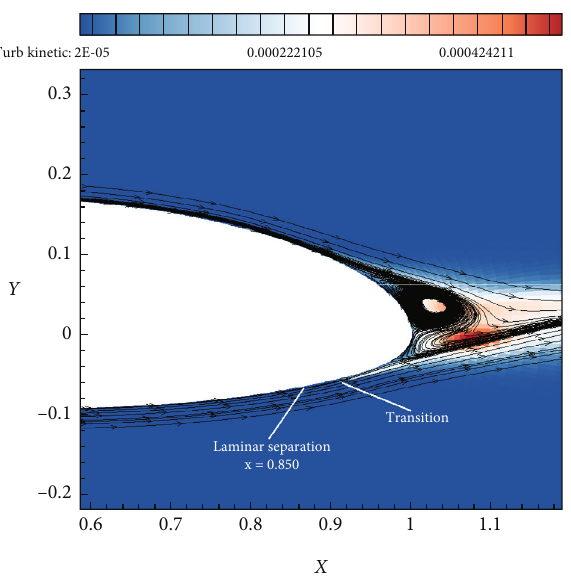
Figure 30: Turbulent kinetic energy distribution of Elliptic264 airfoil ð Re = 0 : 8 E 6, α = 0 ° Þ